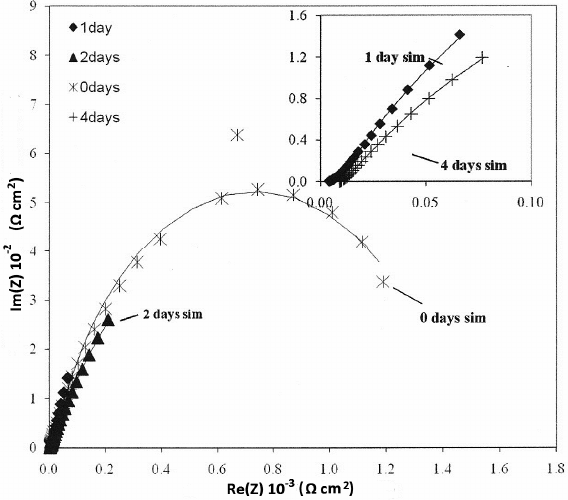
Figure 11. Nyquist plots of impedance spectra, R e (Z), real part of impedance, and I m (Z), imaginary part of impedance, for bare specimens after 0, 1, 2, or 4 days of exposure in a corrosive environment of 3.5 wt % NaCl solution.